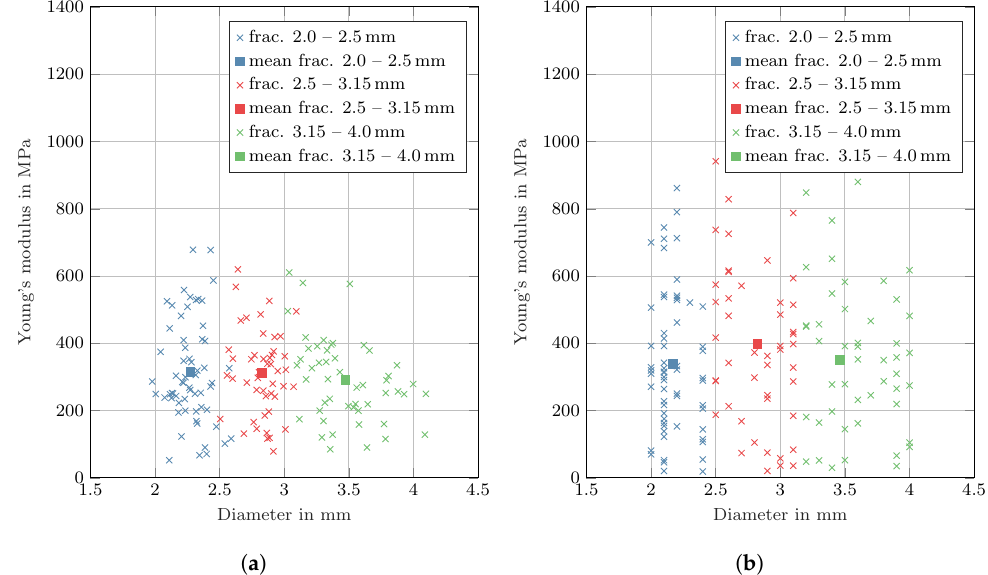
Figure 8. Distribution of Young’s modulus from single particles compression test of Candellila wax- coated and silicone-coated Poraver ® particles from all diameter fractions. ( a ) Poraver ® —Candelilla wax. ( b ) Poraver ® —Silicone.